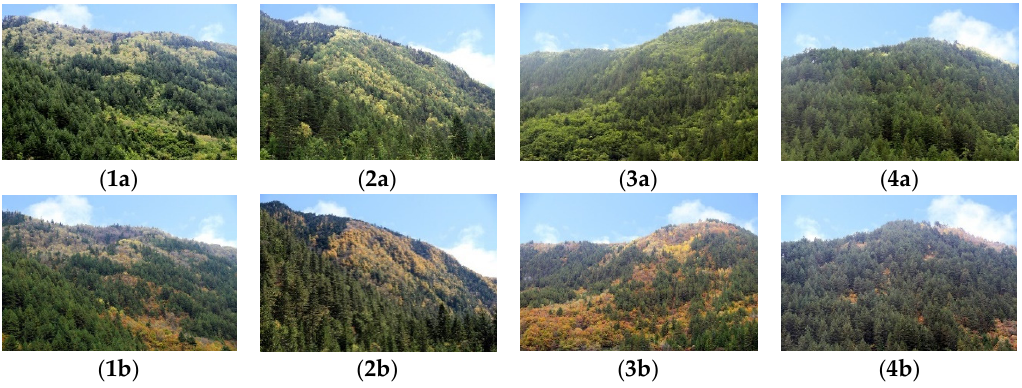
Figure 1. Samples of forest sceneries in Jiuzhai Valley: ( 1a ), ( 2a ), ( 3a ), ( 4a ) are four pictures of different plots, and ( 1b ), ( 2b ), ( 3b ), ( 4b ) are the same scenes as above pictures, but taken in different months. The above photos were taken in September, and those below were taken in October.